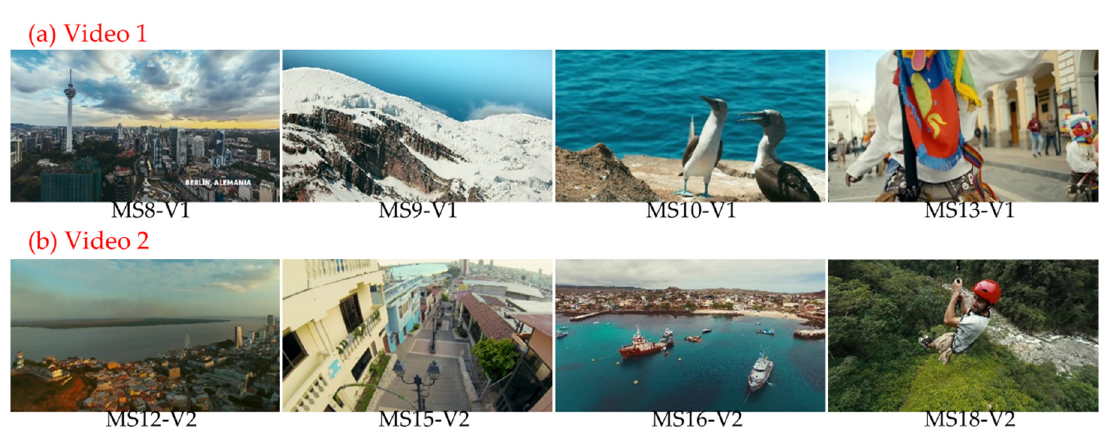
Figure 2. Images of tourist videos extracted as frames: ( a ) The first panel includes the most representative images of each principal topography in Video S1; ( b ) The second panel includes the most representative images of each principal topog- raphy in Video